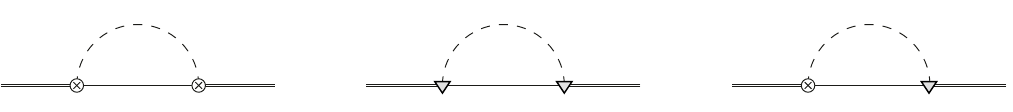
Figure 2 . Self-energy of a heavy pair in a scattering state (solid double line) induced by the quadrupole (crossed vertex) interaction, derivative interaction (triangle vertex) and their mixing. The internal single line stands for a pair in a bound state, the dashed line is the scalar